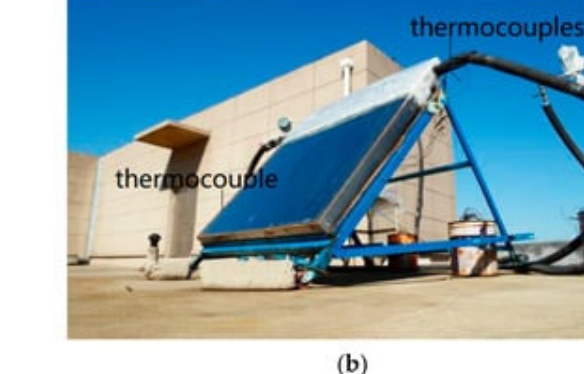
Figure 11. Test rig operation during daytime (adapted with permission from Reference [67], Copy- right 2016, Elsevier).